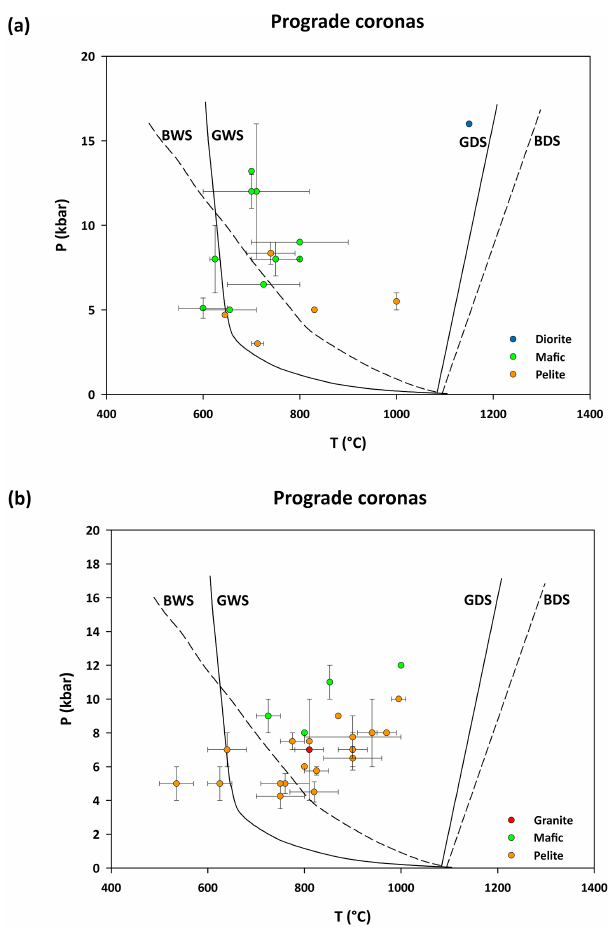
Figure 9. Summary of P – T conditions of formation for coronas reviewed in this study. (a) P – T conditions for prograde